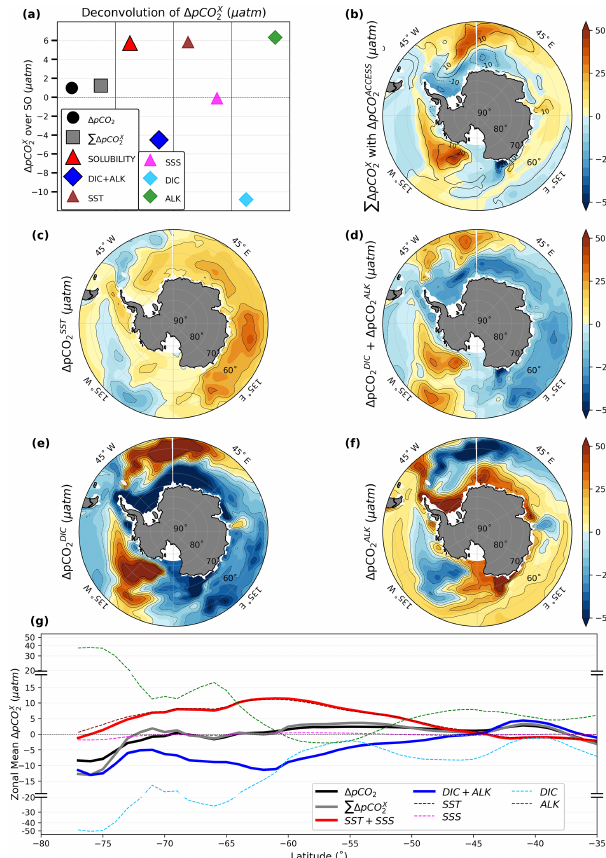
Figure 3. Attribution of changes in annual mean surface pCO 2 over the SO (µatm). (a) Summary of decomposition of pCO 2 over the SO. Simulated difference in pCO 2 (black circle) and sum of contri- butions from all components (grey square, Sect. 2.2). pCO 2 change from solubility (SST + SSS, red triangle) and the sum of DIC and ALK components (blue diamond) are given in the same panel. Indi- vidual contributions from SST (brown triangle), SSS (magenta tri- angle), DIC (cyan diamond), and ALK (green diamond) are also shown. (b) Map of the sum of pCO 2 contributions from all compo- nents (corresponding to grey square in a ) in shading, overlaid with the pCO 2 change simulated by the model as contours (correspond- ing to black circle in a ). Maps of individual pCO 2 contributions from (c) SST (corresponding to the brown triangle in a ), (d) DIC and ALK (corresponding to the blue diamond in a ), (e) DIC (cor- responding to the cyan diamond in a ), and (f) ALK (corresponding to the green diamond in a ). (g) Zonal mean contributions to pCO 2 over the SO (µatm) for simulated (cid:49) pCO 2 (black), sum of contribu- tions from all components (grey), solubility (red), sum of DIC and ALK components (blue), SST (dashed brown), SSS (dashed ma- genta), DIC (dashed cyan), and ALK changes (dashed green) are each shown individually. Note the non-linear scale given for the top and bottom thirds of (g)